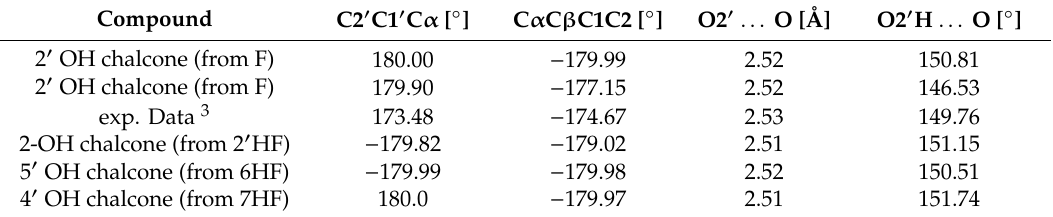
Figure 8. The DFT(B3LYP)/6-31G(d,p)/PCM optimized geometries of the chalcones: ( a ) 2’-OH chalcone (derived from F); ( b ) 2-OH chalcone (derived from 2’HF); ( c ) 5’-OH chalcone (derived from 6HF); ( d ) 4’-OH chalcone (derived from 7HF). The atom numbering is presented for 2’-OH chalcone (derived from F); the same is for 2-OH chalcone, 5’-OH chalcone and 4’-OH chalcone. (Gaussian 09 and GaussView 5.0.8 Paint/Windows 10; Microsoft Office PowerPoint 2007 software). Table 4. The selected geometrical parameters of the most stable structures of the studied chalcones. The atom numbering is the same as for 2’-OH chalcone in Figure 8a.